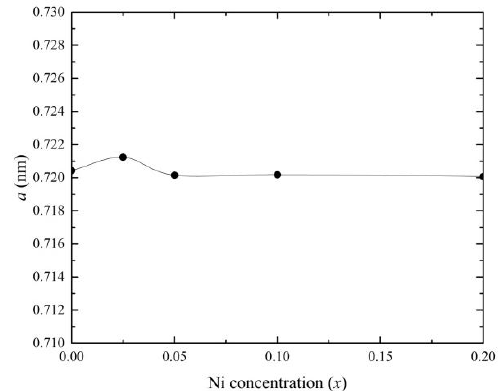
Fig. 2. Concentration dependences of the lattice parameter for TbCo 2 Ni x compounds.